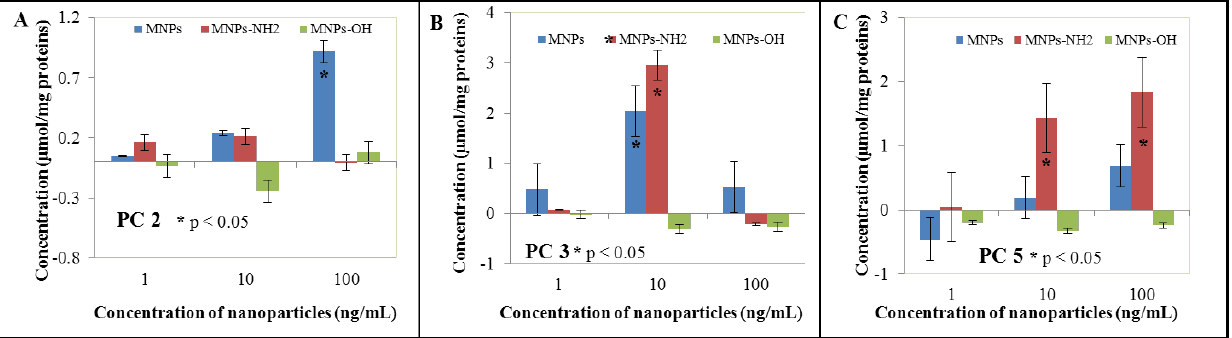
Figure 3. The influence of 0, 1, 10 and 100 ng/mL of magnetic γ-Fe (NPs) and modified magnetic nanoparticles (MNPs—Fe ( A ) concentration PC2, ( B ) concentration PC3 and ( C ) concentration PC5 in treated tobacco BY-2 cells. The results were subtracted from the control, i.e. , non-treated BY-2 tobacco cells. The cells were treated for five